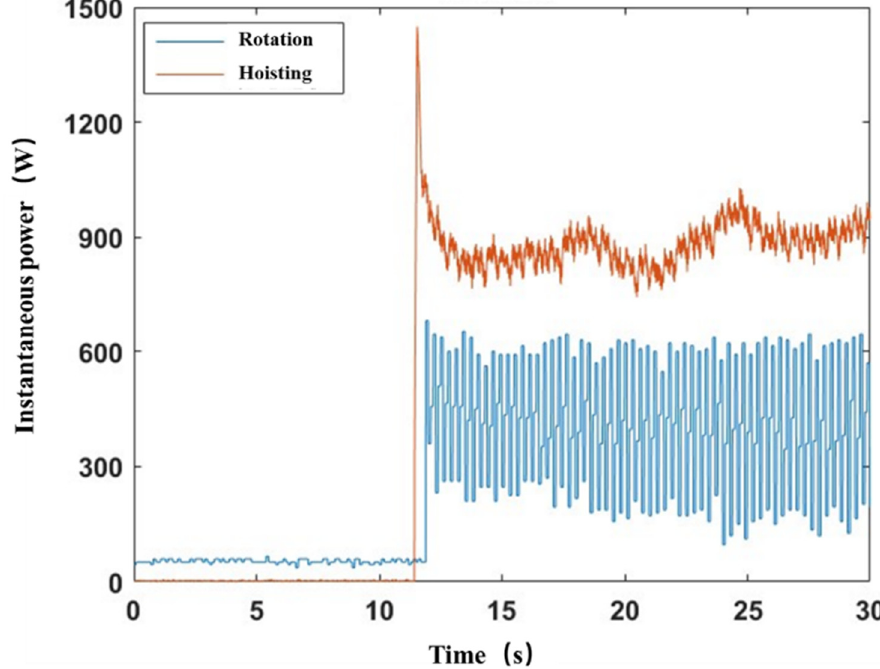
Figure 14. Motor no-load operation diagram: the rotation motor is the blue line, and the hosting motor is the orange line.